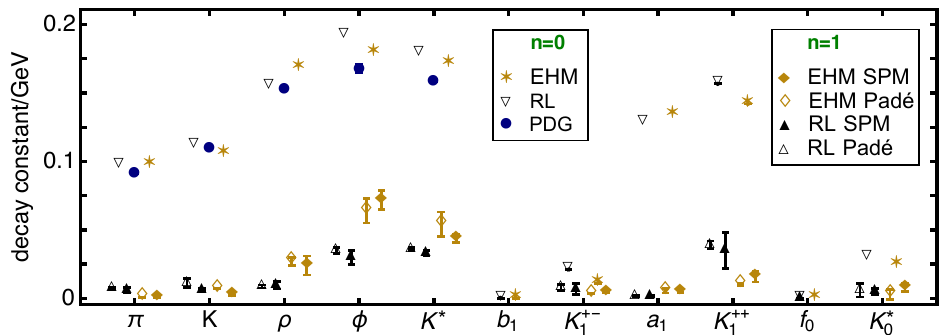
Figure 7. Leptonic decay constants for all states whose masses are reported in Figure 6: ground states, n = 0; lowest lying radial excitations, n = 1. For the excited states, two extrapolation results are presented for each state, viz. one obtained with Padé approximants and the other employing the Schlessinger point method (SPM) [206,207,238,239]—the distinct approaches yield consistent outcomes. Results inferred from data are also plotted, where available [40]